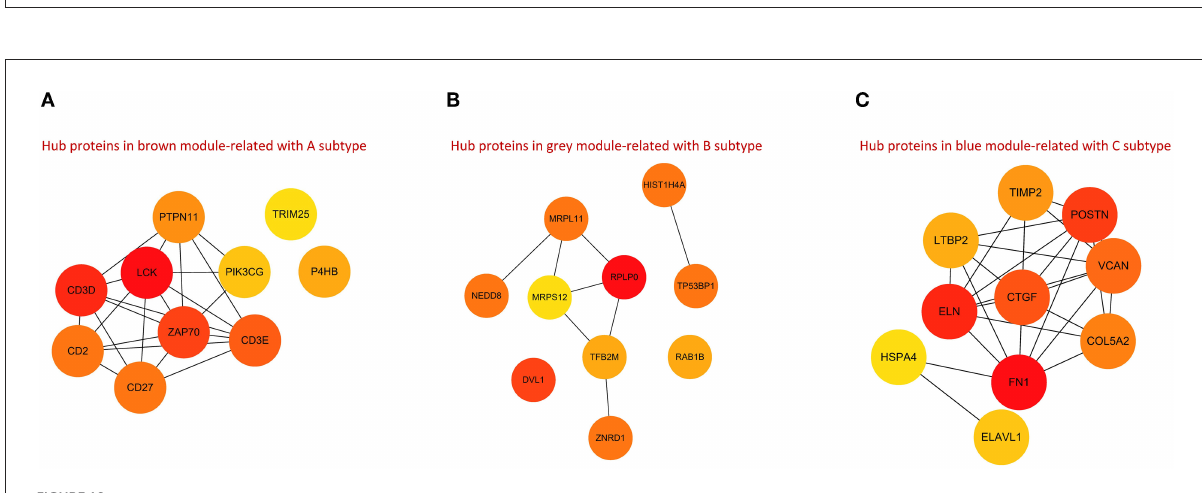
FIGURE10 PPI networks for hub proteins in brown module-related to A subtype (A) , gray module-related to B subtype (B) , and blue module-related to C subtype (C)